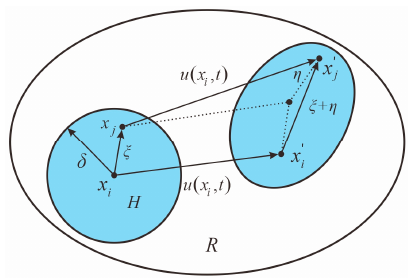
Figure 1. Interaction between material points.